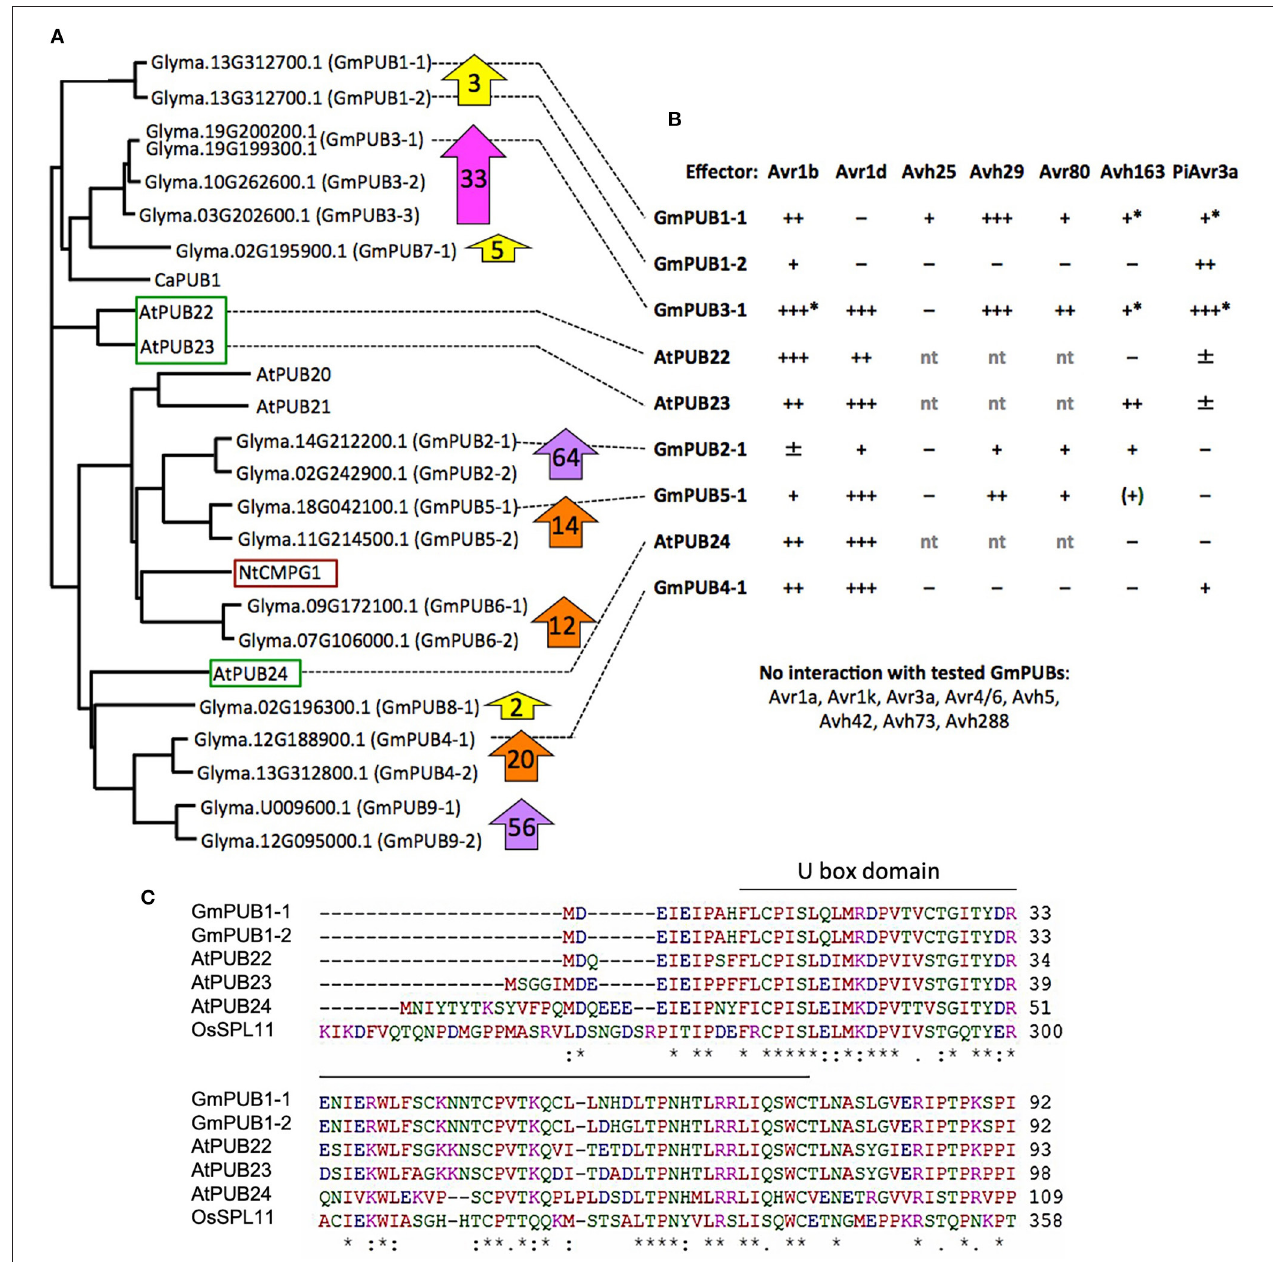
FIGURE 6 | Interaction of GmPUB1-1 and paralogs with multiple RxLR effectors. (A) Distance tree of selected soybean and Arabidopsis PUBs, including known regulators of defense (red box, positive regulator; green box, negative regulators). Glyma, soybean (Williams 82 assembly v2 annotation 1); At, Arabidopsis ; Nt, Nicotiana tabacum ; Ca, Capsicum annuum . ClustalW was used for the sequence alignment and Phylip was used to create an unrooted UPGMA tree. Block arrows indicate fold change in soybean transcript levels following P. sojae infection ( Supplementary Table 3 ). Levels for closely related genes are combined. (B) Interactions of PUBs shown in (A) with RxLR effectors. Most assays were done with pLAW10 (bait vector) and pLAW11 (prey vector). + + + , strong interaction (growth on –Ade and –His); ++ , medium (growth only on –His); + , weak (limited growth on –His); ± , very weak (micro-colonies on –His); –, negative. nt, not tested; *confirmed with bait-prey swap; ( + ) interaction observed only with effector as bait, but not with effector as prey. (C) Comparison of selected U-Box domain sequences from soybean, Arabidopsis and rice. Amino acids with a single color are clusters of amino acids with similar physiochemical properties. Amino acids that are identical in all six proteins are marked with asterisk. Conserved and semi- conserved substitutions are marked with colon and